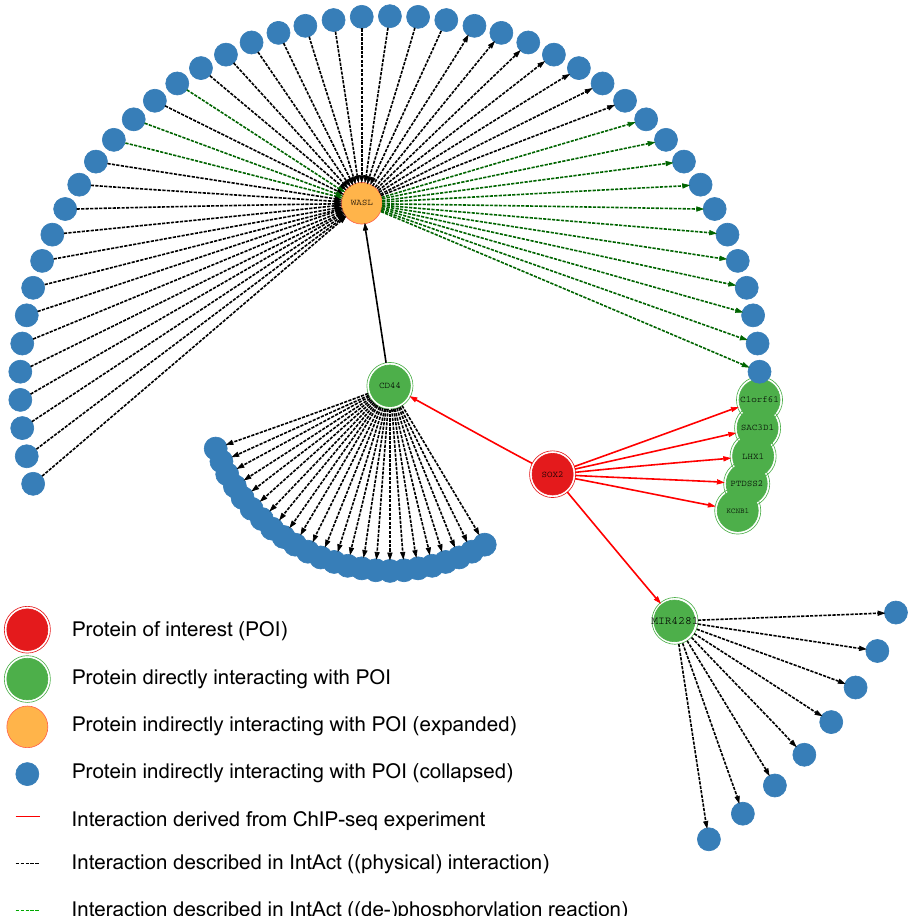
Figure 5: Interactive display of protein-protein interaction wi thin CASSys . Subgraphs can be expanded or collapsed by the user by clicking on the corresponding nodes. The resulting network graph can be exported in scalable vector graphics format